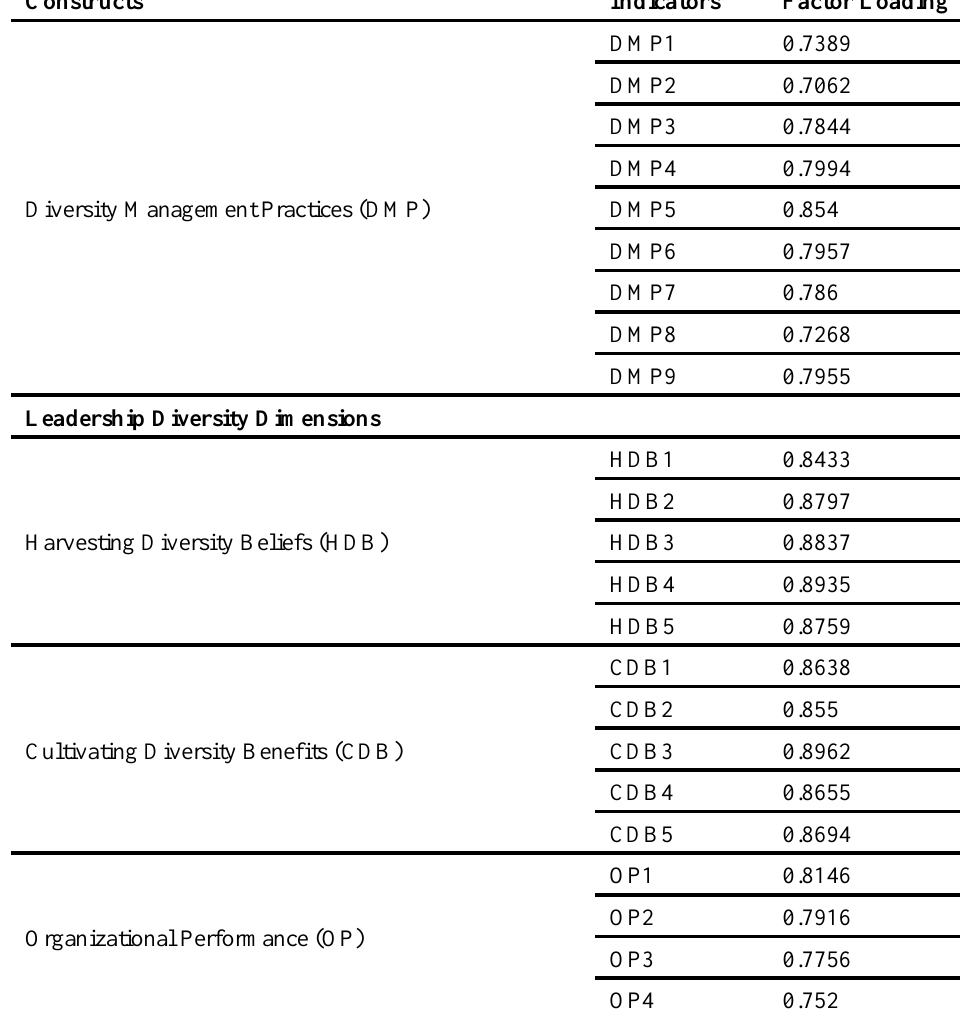
Table.3. Measurement Model (Outer